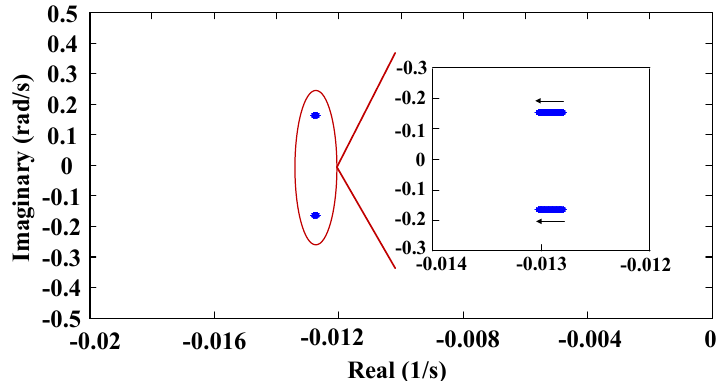
Figure 10. Root locus of the ultralow-frequency oscillation. Table 3. Damping ratio and frequency with increasing of PV output power.